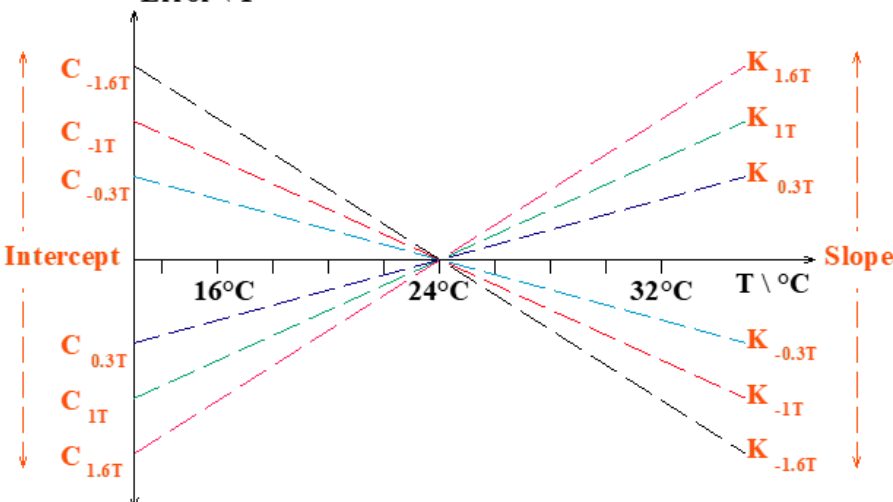
Figure 11. Error plot extracted from Figure 10 when subtracting the instrument output response from the NMR reading. A set of slope values K MF and intercept values C MF is obtained. Therefore, relating the slope values given by K MF and the y-intercept values given by C MF to the instrument magnetic field value outputs gives the relation plots as shown in Figures 12 and 13.